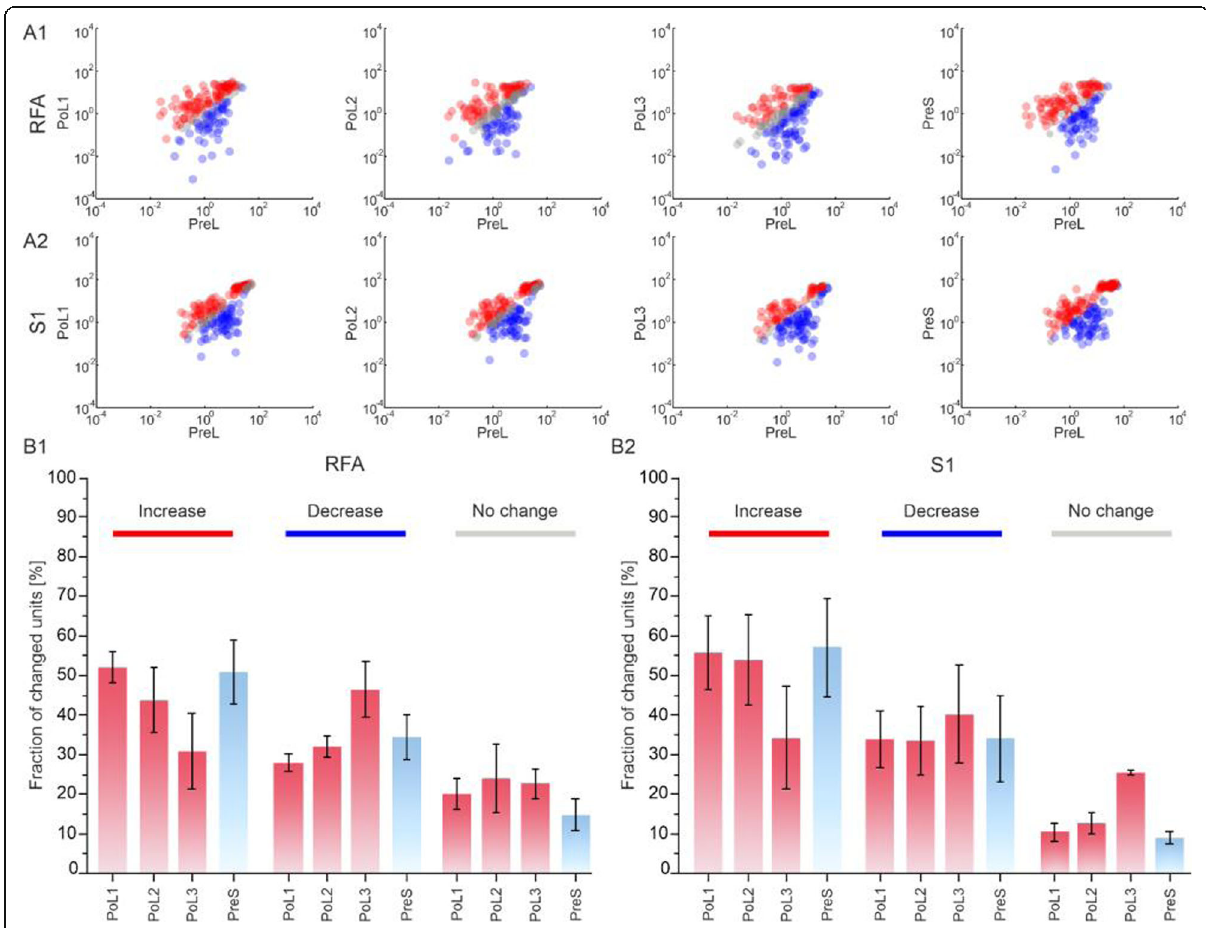
Fig. 3 Effect of the lesion on the firing units. Per unit correlation for RFA ( A1 ) and S1 ( A2 ) between baseline firing rates (x-axis, PreLesion (PreL)) and firing rates of immediately post lesion phase and pre stimulation session (y-axis, PostLesion (PoL1 – 3), Pre Stim (PreS)), respectively. Data is shown in scatter plots, where colors represent units that significantly (i.e. according to the bootstrapping methods described in the Materials and Methods) increased (red), decreased (blue), or remained stable (grey). The global number of units in RFA ( A1 ) was 54.7 ± 3.8; in S1 ( A2 ) the total number of units was 58.7 ± 9.5. Bottom: B1) for RFA and B2) for S1. Average fraction of units that increased (red bar), decreased (blue bar) or no changed (grey bar) their firing with respect to the baseline period of recording (i.e. PreLesion, PreL) calculated for the immediately post lesion phase (i.e. PostLesion, PoL1 – 3, red) and pre stimulation session (i.e. PreStim, PreS, light blue). Data are reported as mean ± SEM (standard error of the